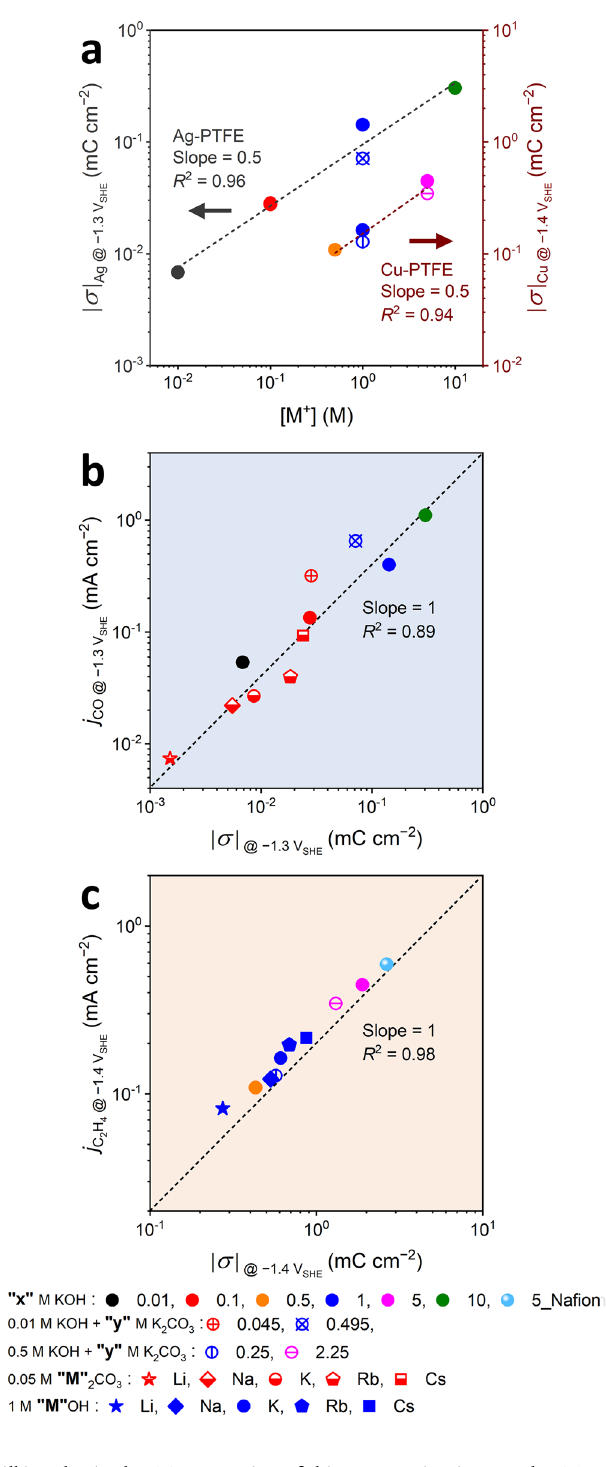
Fig.4|Reactionkineticstudies.a Correlationplotsbetween[M + ]and| σ |fortheAg andCuelectrodes.Correlationplotsof b j CO ontheAgelectrodeand c , j C2H4 onthe Cuelectrodewith| σ |.Thedatawascollectedat − 1.3V SHE fortheAgelectrode(CO 2 - to-CO formation) and − 1.4 V SHE for the Cu electrode (CO-to-C 2 H 4 formation). Electrolytes used for gathering these data can be classi fi ed into fi ve different categories: KOH electrolytes with different concentrations ( fi lled circles), 0.01M KOH electrolytes with additional K 2 CO 3 salt (double-crossed circles), 0.5M KOH electrolytes with additional K 2 CO 3 salt (single-crossed circles), 0.05M M 2 CO 3 electrolytes (half- fi lled symbols), and 1M MOH electrolytes ( fi lled symbols), where M is Li, Na, K, Rb, and Cs. In addition, a result collected on the Na fi on-coated Cu electrode in 5M KOH electrolyte (a fi lled circle with pale blue color) was also provided. Here, the total M + concentration and its identity are distinguished by color and symbol shape, respectively. Guidelines for the slopes are indicated by a dashed